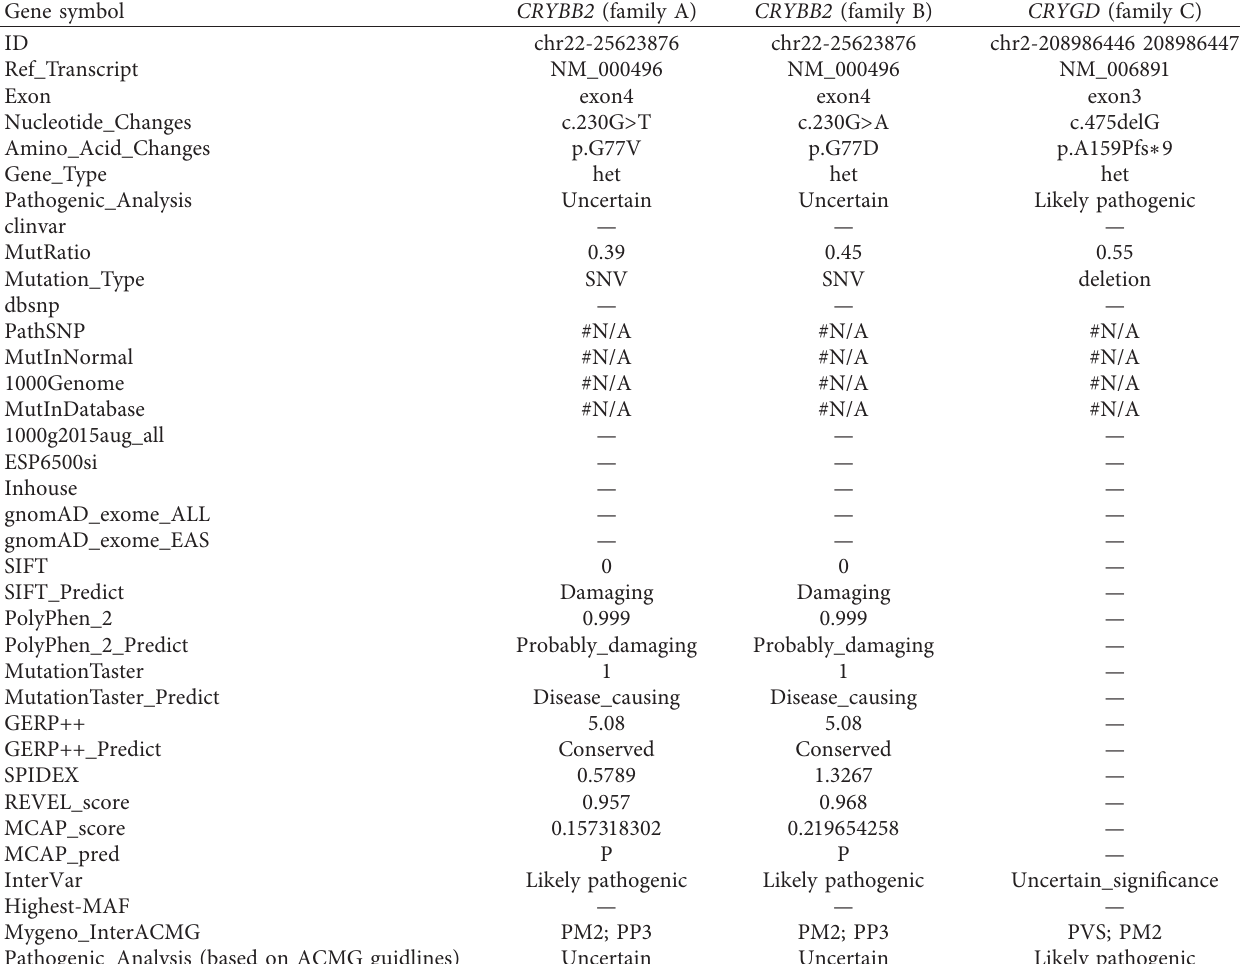
Table 3: Summary of function prediction of three likely pathogenic variants.